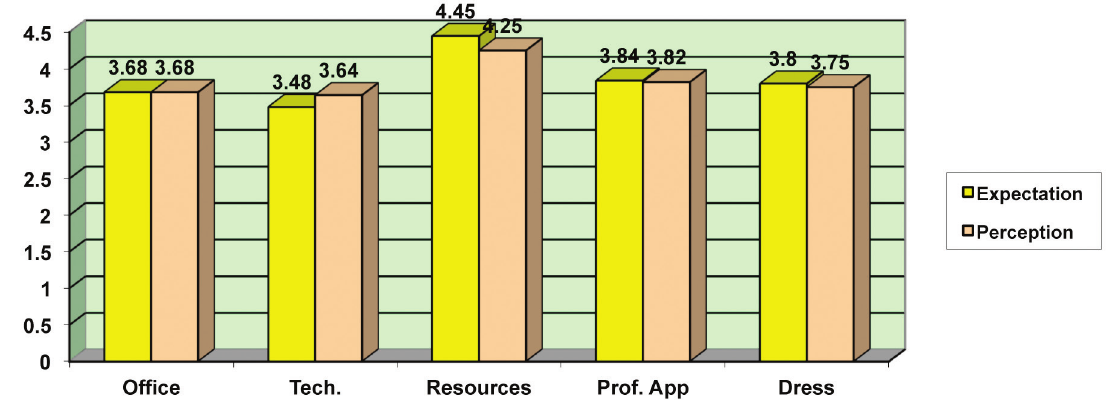
Figure 1: Tangibles: Expectations versus